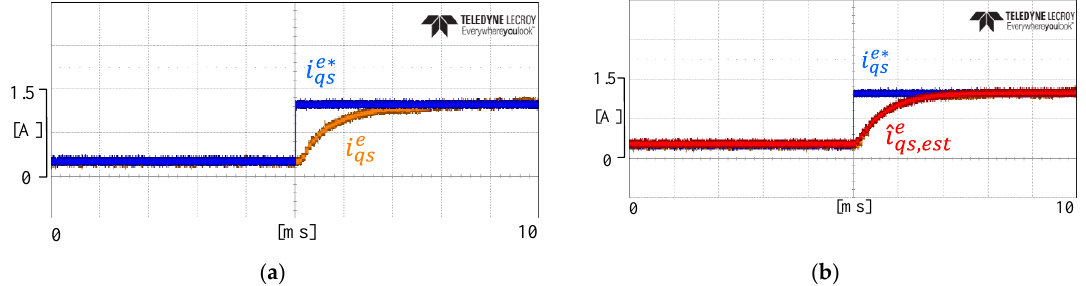
Figure 15. The phase current sampled through shunt resistor with the proposed current estimation method: ( a ) Reference q-axis current and real current; ( b ) reference q-axis current and estimated current.